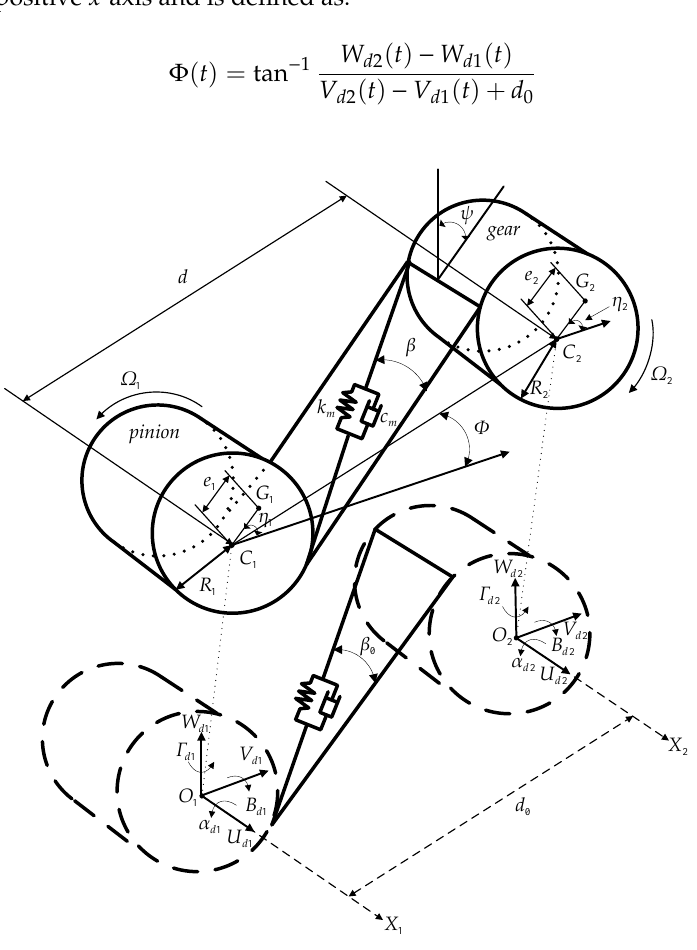
Figure 3. Generalized coordinates for the helical gear pair.